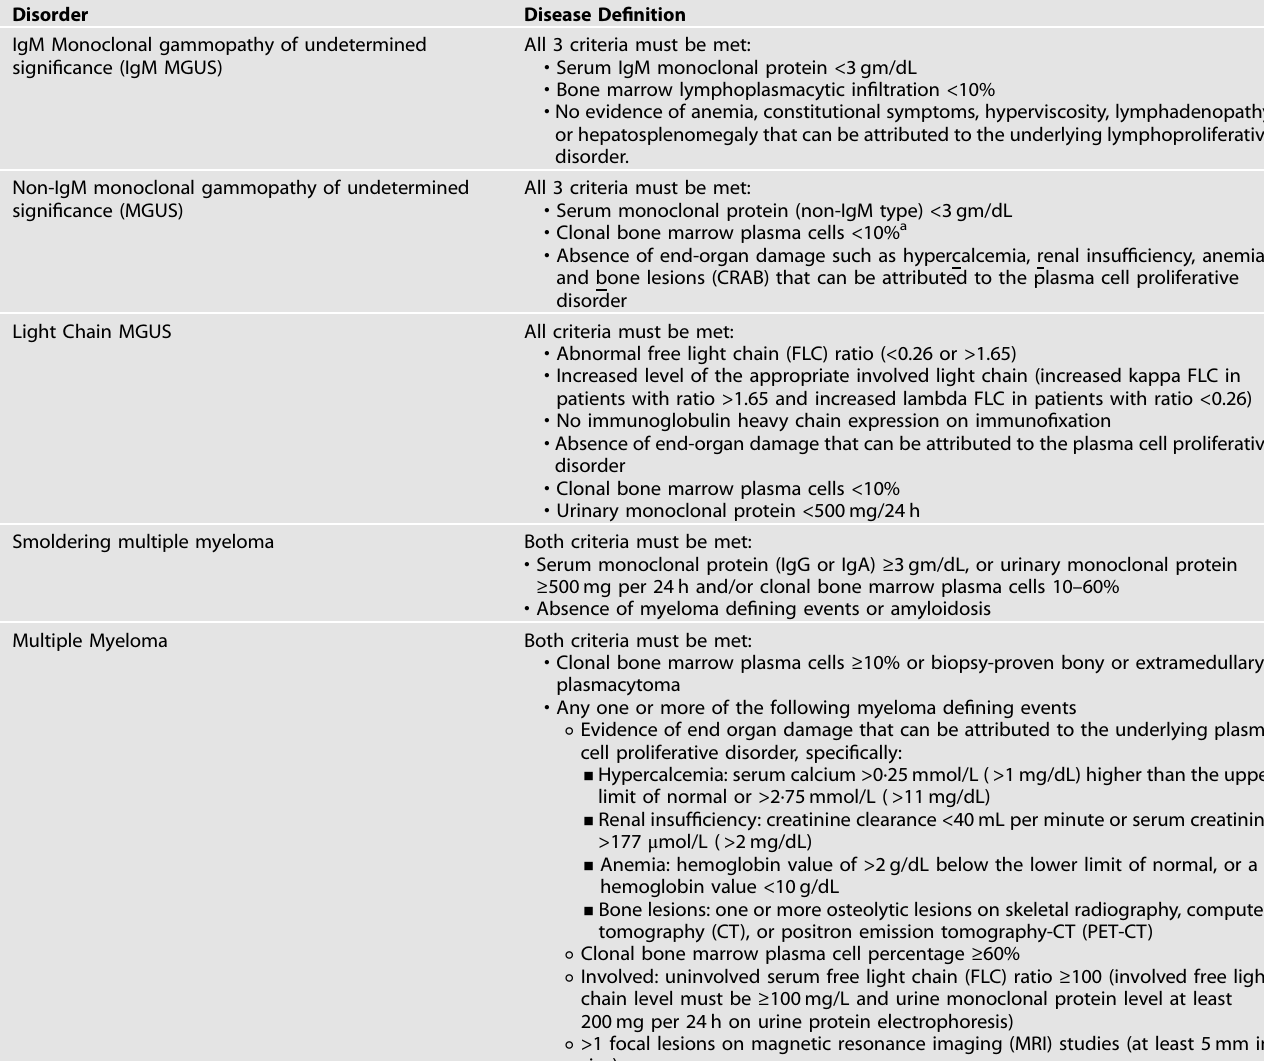
Table 1. International Myeloma Working Group Diagnostic Criteria for Multiple Myeloma and Related Plasma Cell